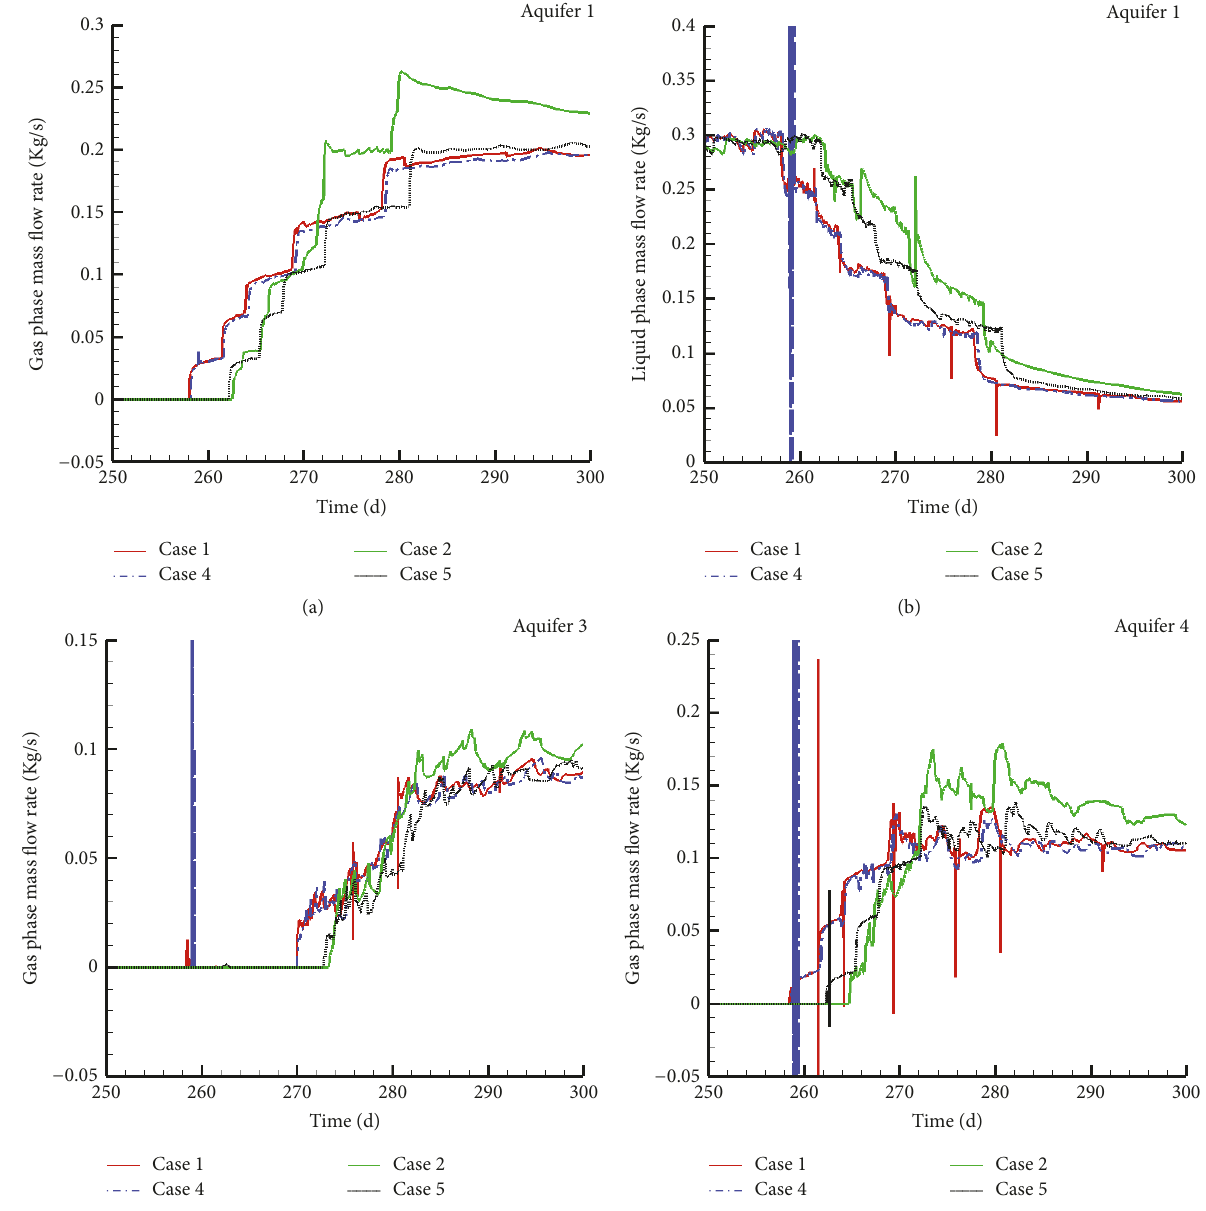
Figure 19: Differences of fluids dynamics at the outlet/inlet of each aquifer between momentum model and corresponding EPM model of various